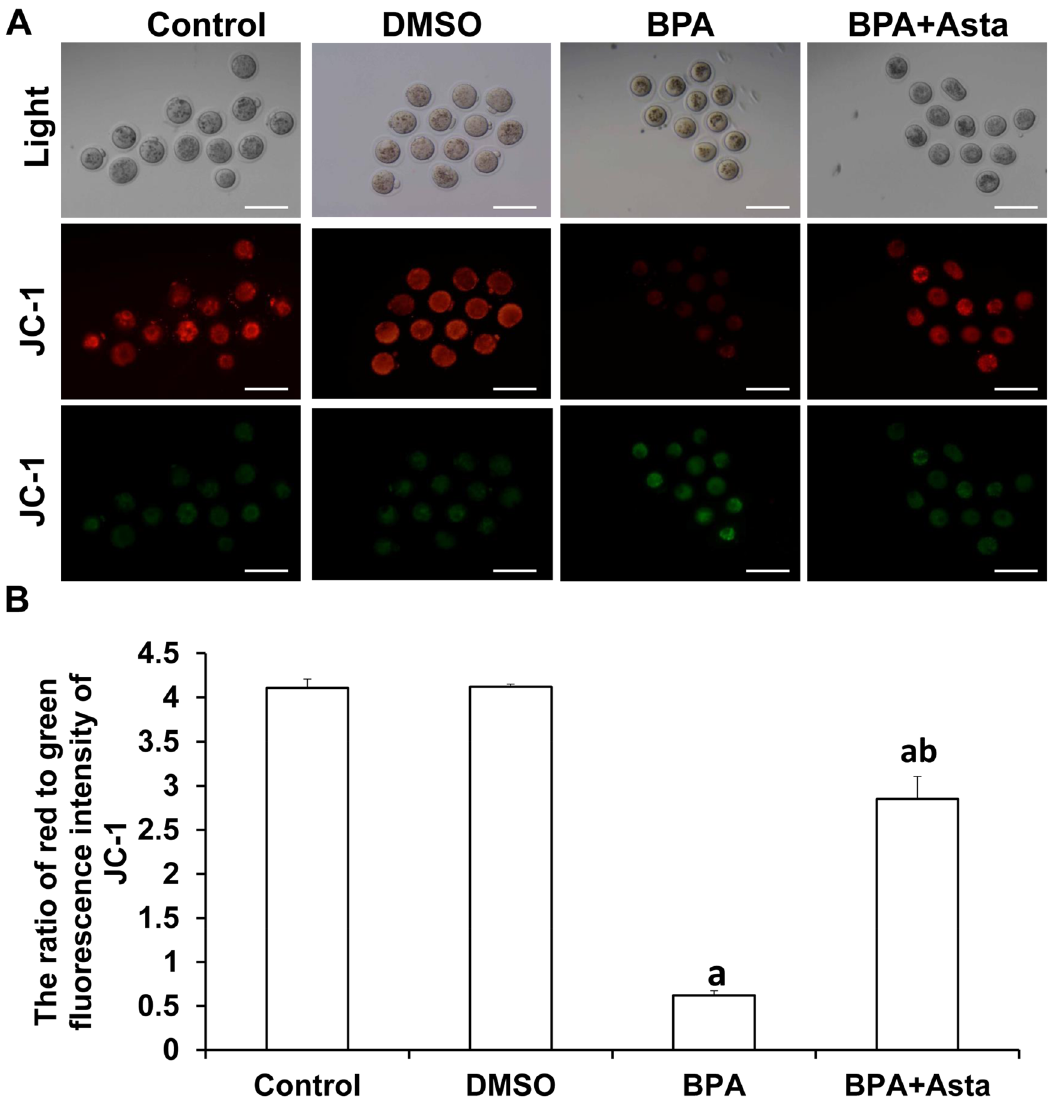
Figure 7. Analysis of mitochondrial membrane potential in oocytes. ( A ) JC-1 probe was used to detect the mitochondrial membrane potential in oocytes. JC-1 forms J-aggregates and produces red fluorescence under normal mitochondrial membrane potential (Scale bar, 200 μm). Under reduced or lost mitochondrial membrane potential, JC-1 exists in J-monomers and produces green fluorescence. ( B ) The average fluorescence intensity was analyzed in oocytes (N = 10). Compared with control, a P < 0.05; and compared with BPA group, b P < significantly increase the ROS levels in pig embryos, causing intracellular cytochrome C release, mitochondrial and DNA damages, and apoptosis 48 . It is shown that antioxidants can reduce the production of ROS 28 , increase the expression levels of antioxidant genes in cells, and improve the maturation, fertilization and early embry- onic development capabilities of oocytes 49 . Jia et al . 30 reported that 2.5 μM astaxanthin significantly reduced the production of ROS in oocytes and improved the quality of oocytes 30 . In this study, we have obtained similar results, which showed that the BPA treatment significantly increased the ROS levels in oocytes and reduced the maturation rate of oocytes. On the other hand, astaxanthin significantly reduced the production of ROS in oocytes, significantly increased the maturation rate of oocytes, and significantly relieved the oxidative stress damage in oocytes caused by BPA. The whole process of follicular development is accompanied by the continuous proliferation of granulosa cells, and the steroid hormones synthesized and secreted by granulosa cells and theca cells further stimulate the devel- opment of follicles 50 . BPA is reported to inhibit the proliferation of granulosa cells, interfere with the synthesis of steroid hormones, and interfere with the follicular development 50 . Since the volume of oocytes hardly changes during the development of preantral follicles with the diameter of 110–130 μm 50 , the adherence area of follicles may reflect the proliferation of granulosa cells. Additionally, PCNA is involved in regulating DNA synthesis and is an important indicator of cell proliferation 50 . In this study, BPA was added to the mouse preantral follicle